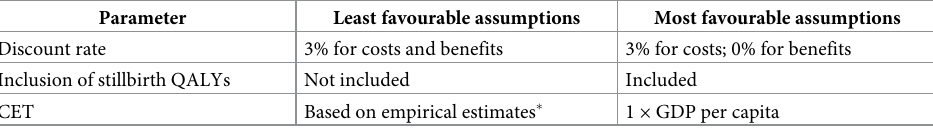
� CETs were based either on estimates from Ochalek and colleagues or Woods and colleagues. See S1 Appendix A2.8 for more